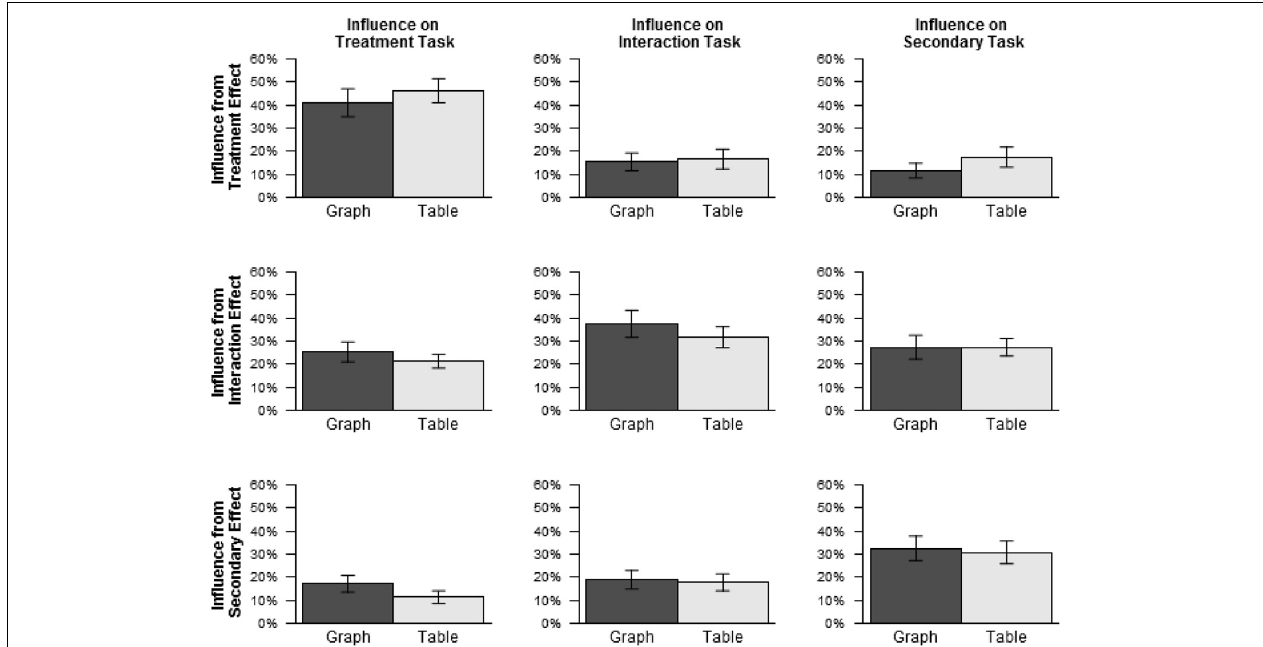
FIGURE 5 | Influence by influencing effect and influenced task for graphs and tables (Experiment